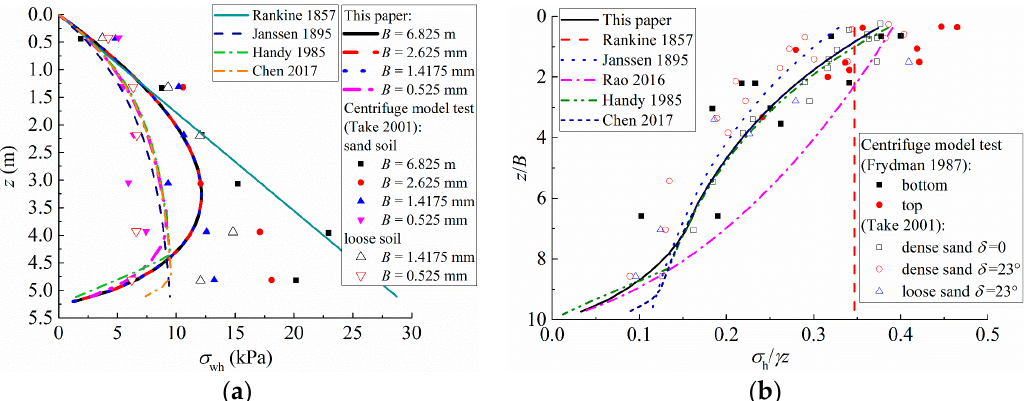
Figure 11. Comparison of ( a ) the active earth pressure and ( b ) its normalized distribution with centrifuge model tests and theoretical results by other scholars.